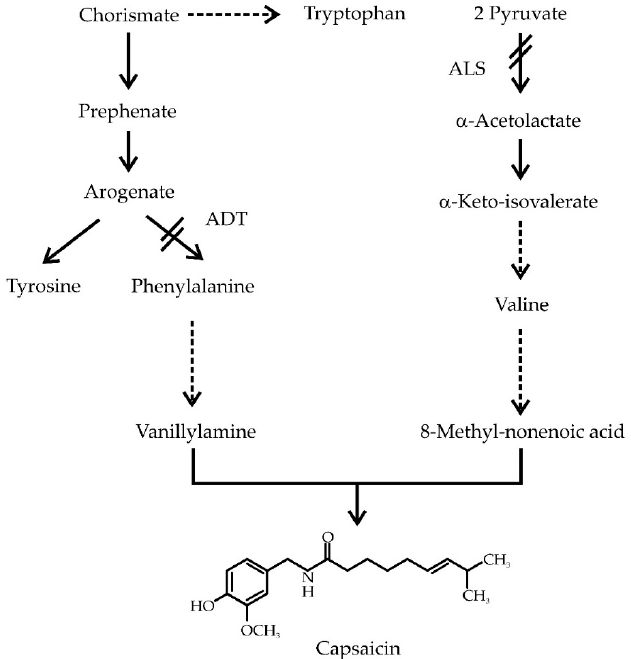
Figure 1. Schematic representation of phenylalanine (Phe) and valine (Val) biosynthetic pathways and their relation to capsaicinoids (CAP) synthesis.